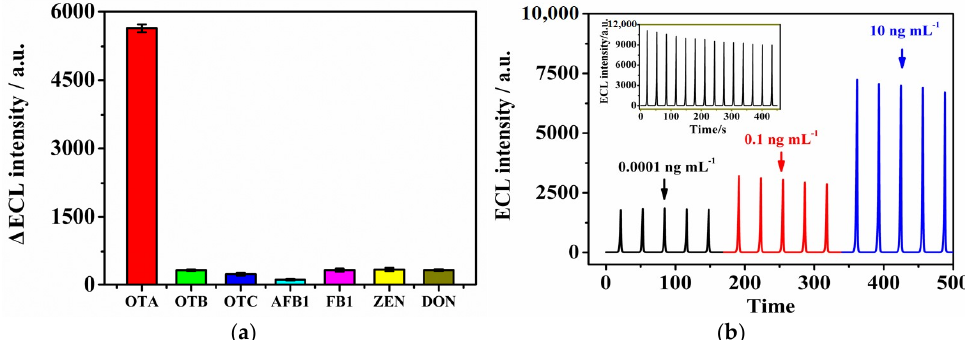
Figure 8. ( a ) Calibration curve of the ECL − RET immunosensor for OTA detection. (PMT: 700 V, scan rate: 100 mV/s, magnification: 2); ( b ) stability of constructed immunosensor with 0.0001, 0.1 and 10 ng/mL OTA in 0.1 M PBS containing 20 mM K 2 S 2 O 8 and 0.1 M KCl.